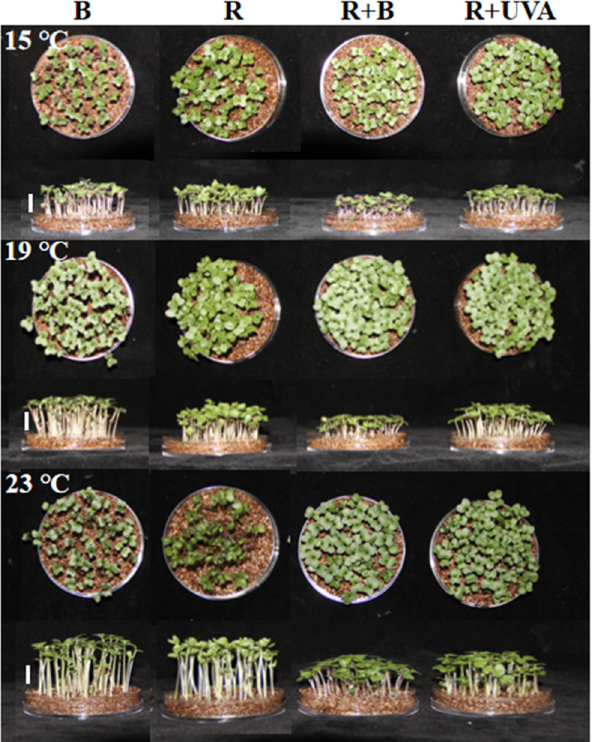
Figure 2. Morphology of broccoli sprouts grown for 5 d under different light [blue (B), red (R), mixture of R and B (R+B), as well as mixture of R and UVA (R+UVA)] and air temperature (15, 19, and 23 °C) regimes. The scale bar refers to 1 cm length.